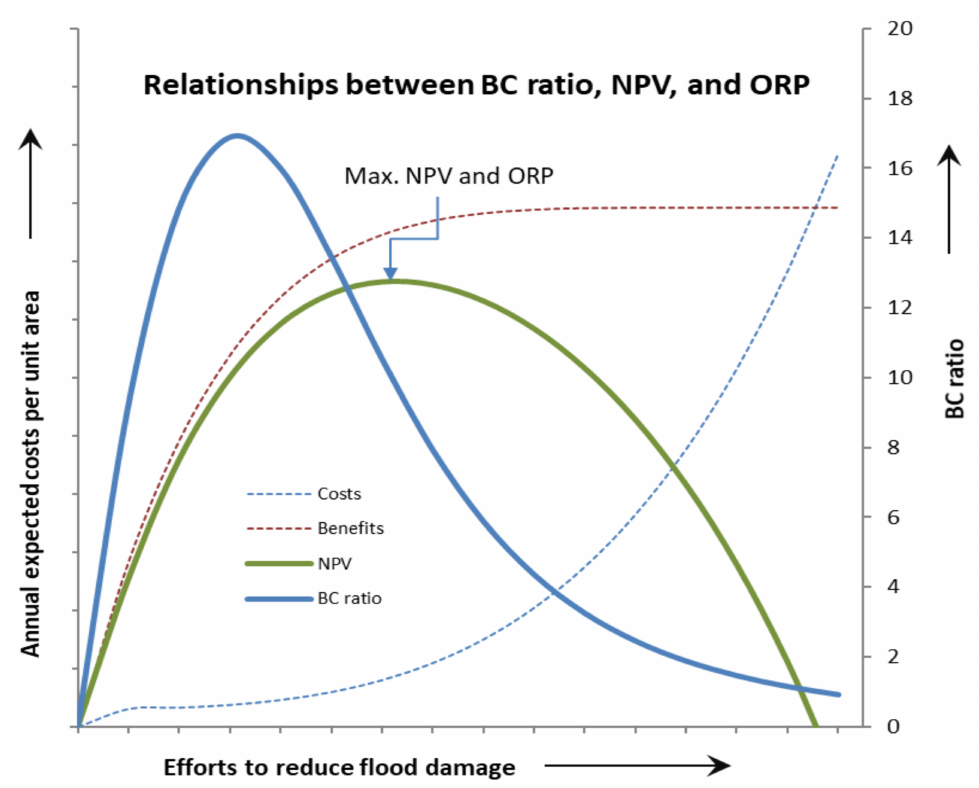
Figure 5. Illustration of flood management costs, benefits, benefit–cost ratio (BC ratio), net present value (NPV), and ORP concepts and their relative variations as e ff orts to reduce flood damage